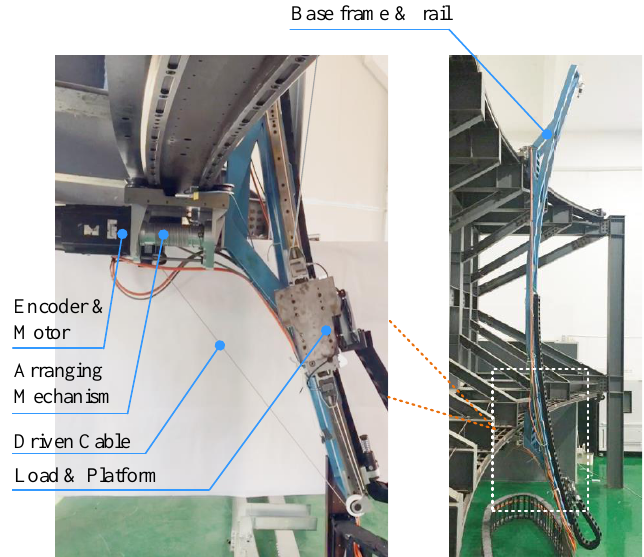
Figure 4. Component of the flexible cable driven system.